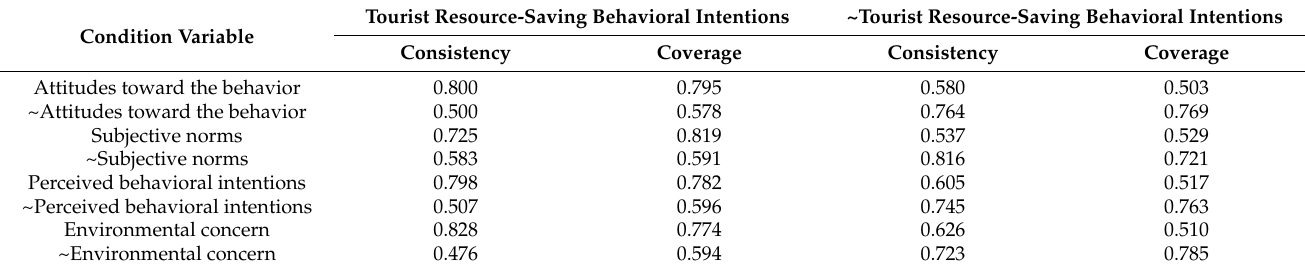
Table 10. Necessary condition analysis in the model of tourist resource-saving behavioral intentions.